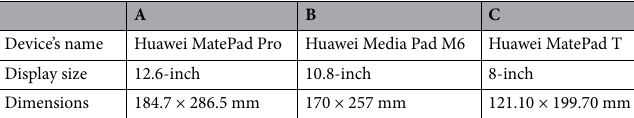
Table 2. Selected devices’